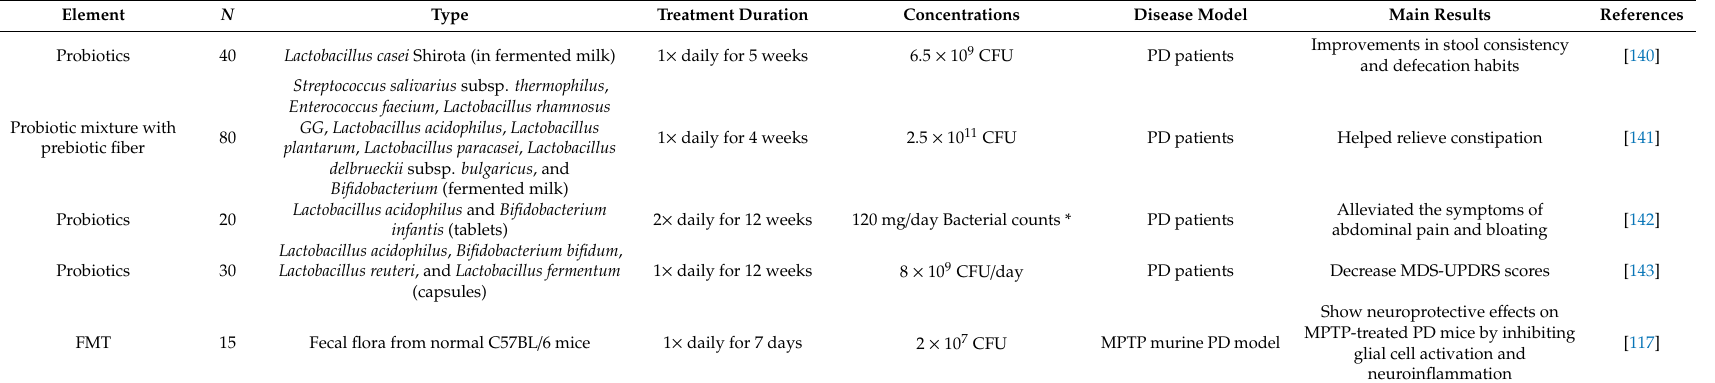
Table 2. Comparison of studies using microbial treatment in Parkinson’s disease (PD) including a study with an animal model [72] (reused with permission, license number: 4637600311198, Springer Nature and Copyright Clearance